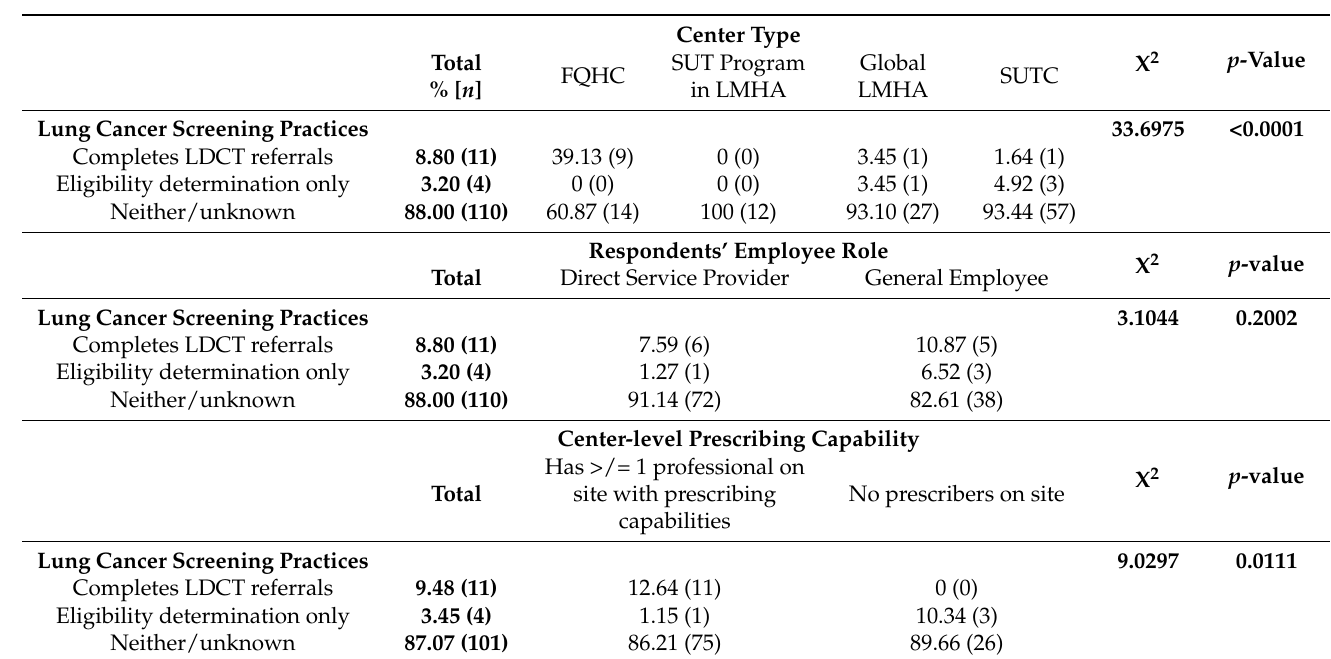
Table 2. Lung Cancer Screening Practices by Center Type, Employee Role, and Prescribing Capability (n = 125 healthcare